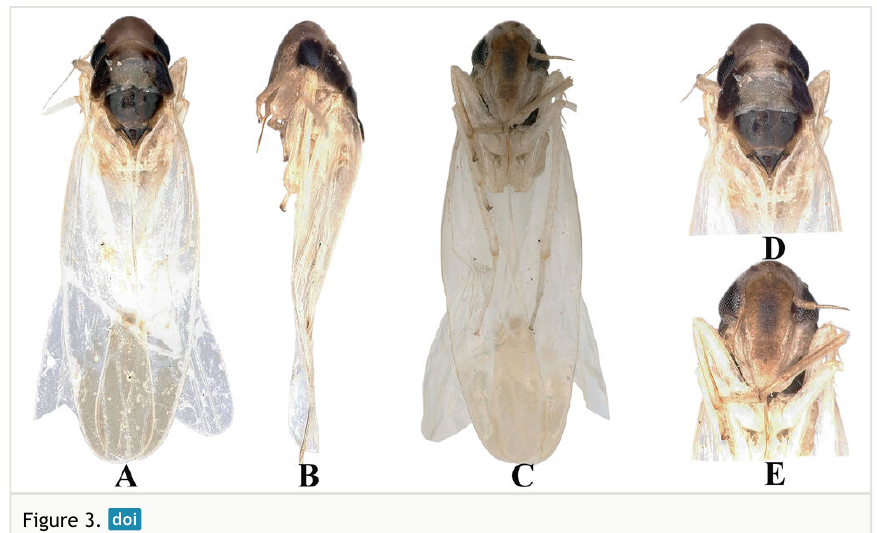
and D). Scutellum black in whole (Fig. 3A and D). Forewing faint brown (Fig. 3A and C). Abdominal apodemes broad, extended to 4 sternite (Fig. 4C). th